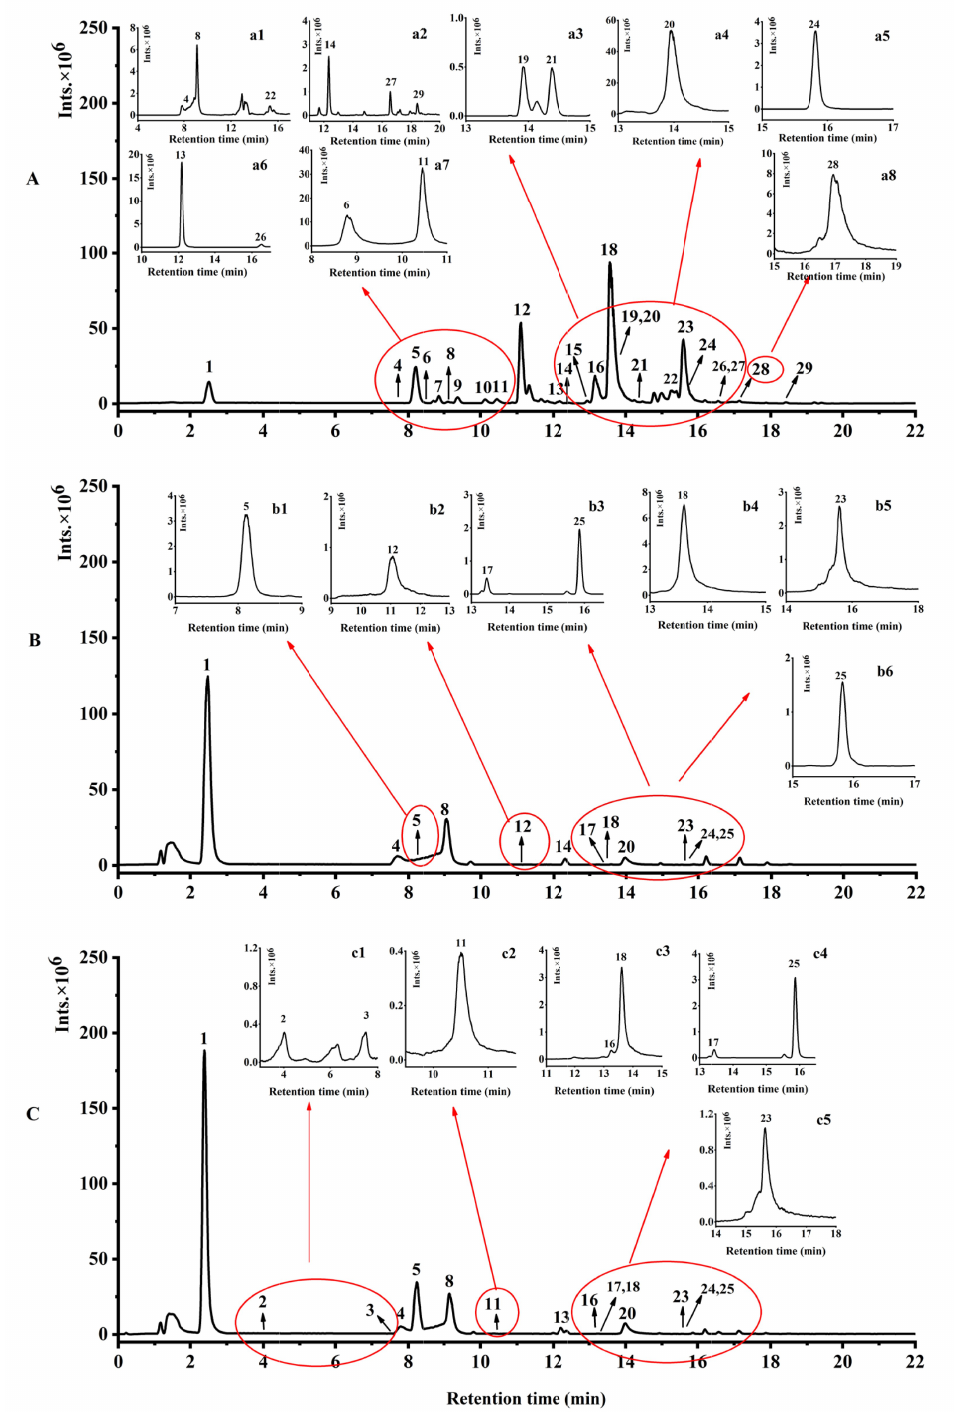
Figure 1. Negative ion current chromatograms of three phenolic fractions from water caltrop ( Trapa quadrispinosa Roxb.) husk. ( A – C ) Represents free phenolic, esterified phenolic and insoluble-bound phenolic fractions, respectively. Panels a1–a8 are the extracted ion chromatograms from ( A ); b1–b6 are the extracted ion chromatograms from ( B ); c1–c5 are the extracted ion chromatograms from ( C